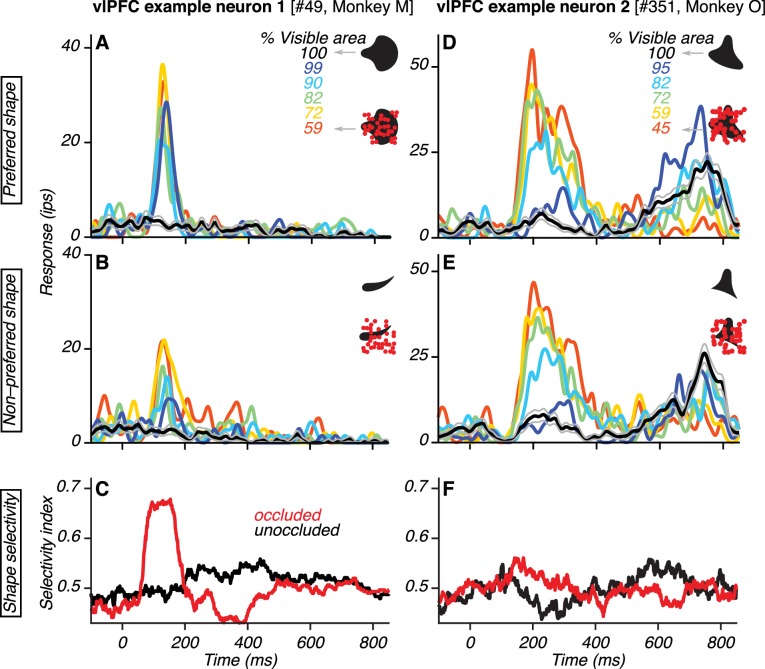
Responses of example vlPFC neurons.(A–B) Responses of one neuron to its preferred and non-preferred shape (compare A and B) at different occlusion levels (colors). Responses to unoccluded stimuli were weak (black; gray lines show standard error of the mean) whereas responses to occluded stimuli were stronger (colors). For PSTHs, σ was 10 ms. (C) Neuronal shape selectivity across time for unoccluded (black) and occluded (red) stimuli quantified by a sliding window ROC curve analysis (see Materials and methods). (D–E) Responses of a second vlPFC neuron, showing comparable responses to both shapes (compare D and E). Responses to unoccluded stimuli were weak whereas responses to occluded stimuli were stronger. The test stimulus was extinguished at 600 ms and the elevation in response beyond this time point was due to the saccadic response. (F) Neuronal shape selectivity across time (same format as in C).